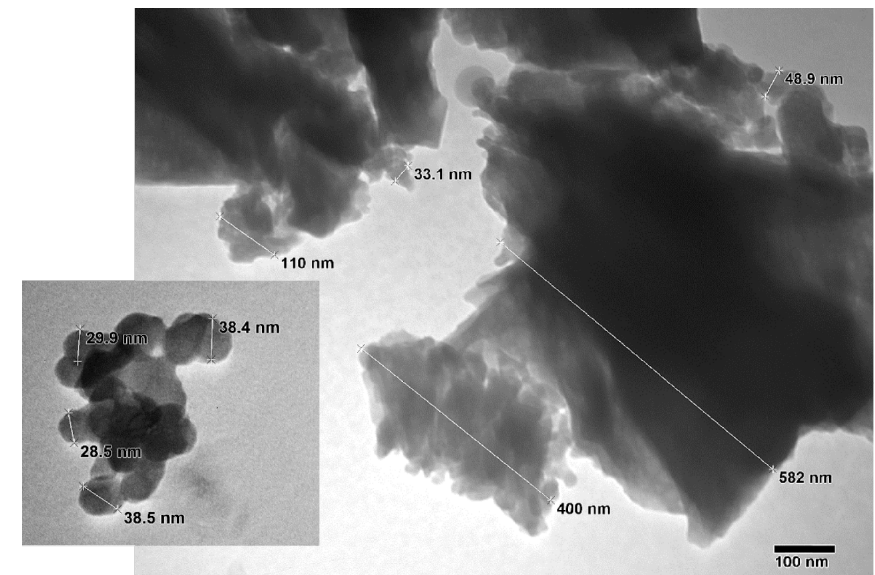
Figure 7. TEM image of NaOMe/zeolite catalyst synthesized via ball-milling